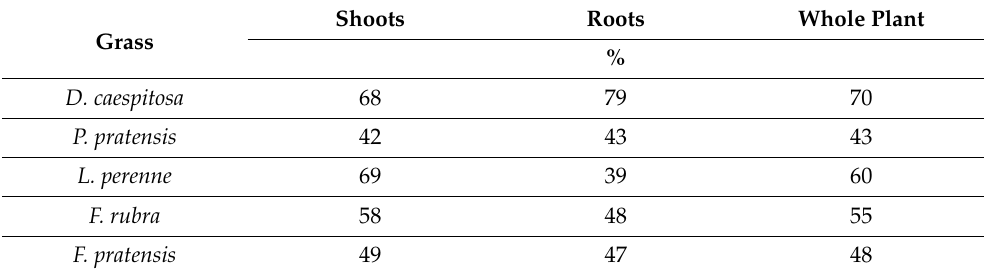
Table 3. Tolerance index.